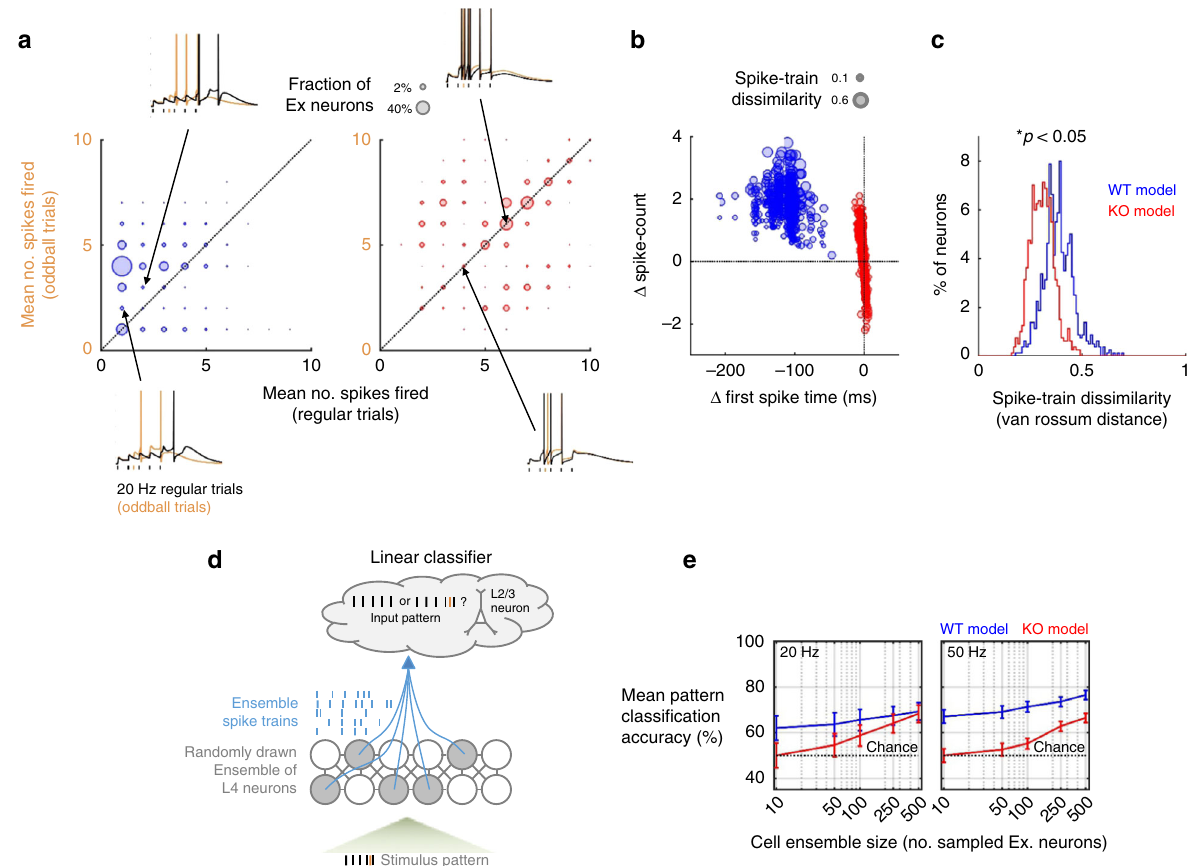
Fig. 10 Impaired sensory coding by neural ensembles in a model of Fmr1-KO layer 4 network. a Network-wide representation of an extra oddball stimulus inserted into a regular stimulus train (orange tick, single trial example) by fi ring changes. Circle sizes: fraction of neurons at each coordinate. Insets: simulated V membrane of representative neurons for regular (black) and oddball (orange) trials. Fmr1 + /Y model neurons typically increased fi ring rates on the oddball trial, but Fmr1 − /Y neurons only weakly represented the presence of the oddball stimulus by change in fi ring rate (bulk of points on diagonal). b Different coding schemes underlie representation of sensory input details for simulated Fmr1 + /Y and Fmr1 − /Y networks. Fmr1 + /Y neurons typically increased their fi ring rate and advanced their fi rst spike in response to an extra oddball stimulus. Fmr1 − /Y neurons showed in fl exibility in their spike rate